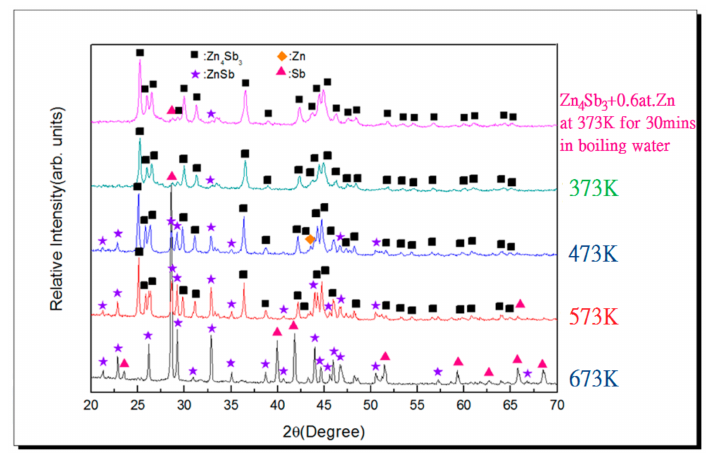
Figure 2. XRD patterns of bulk specimens with 0.6 at. % Zn rich composition vacuum sintered at different temperatures for 30 min.